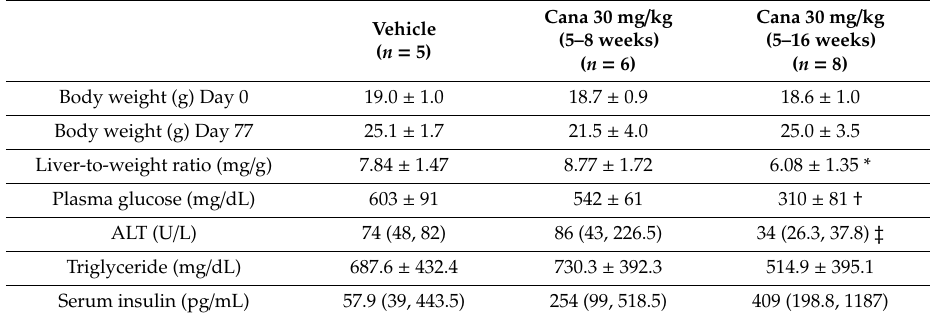
Data are mean ± SD or the median and inter-quartile ranges. * p < 0.01 vs. Cana initial (5–8 weeks); † p < 0.001 vs. vehicle and vs. Cana initial (5–8 weeks); ‡ p < 0.01 vs. vehicle and vs. Cana initial (5–8 weeks), Cana canagliflozin; ALT, alanine